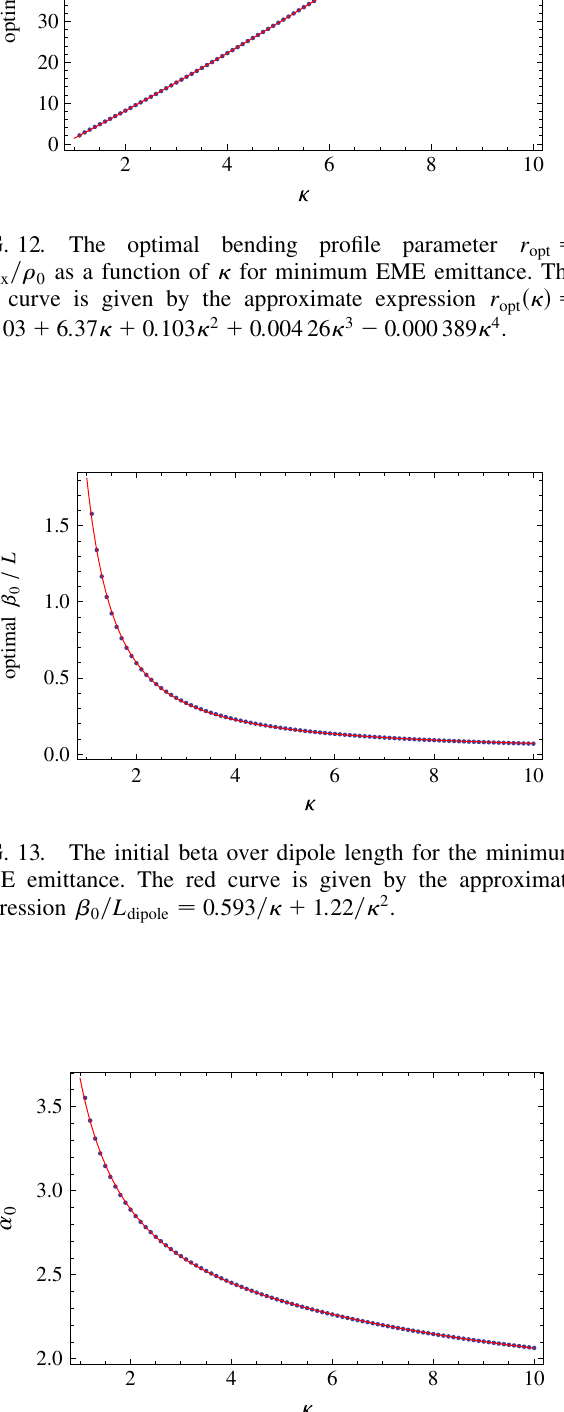
FIG. 11. Maximum improvement factor for EME emittance as =B . The blue dots are the exact values. a function of (cid:12) ¼ B max ref The red curve is given by the approximate expression 1 = ^ F ð (cid:12) Þ ¼ (cid:1) 0 : 349 þ 1 : 9 (cid:12) (cid:1) 0 : 366 (cid:12) 2 þ 0 : 0364 (cid:12) 3 (cid:1) 0 : 001 37 (cid:12) 4 . The val- ues at (cid:12) ¼ 2 , 4, and 6 agree with the results in [12].